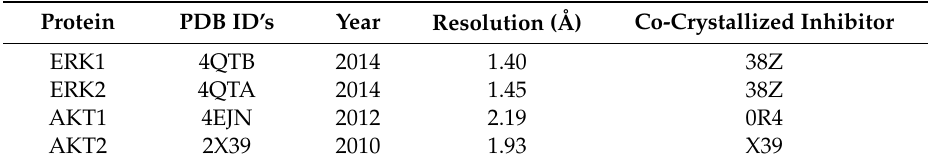
Table A9. Crystallographic structures of ERK1 / 2 and AKT1 / 2 obtained from Brookhaven RCSB PDB (Protein Data